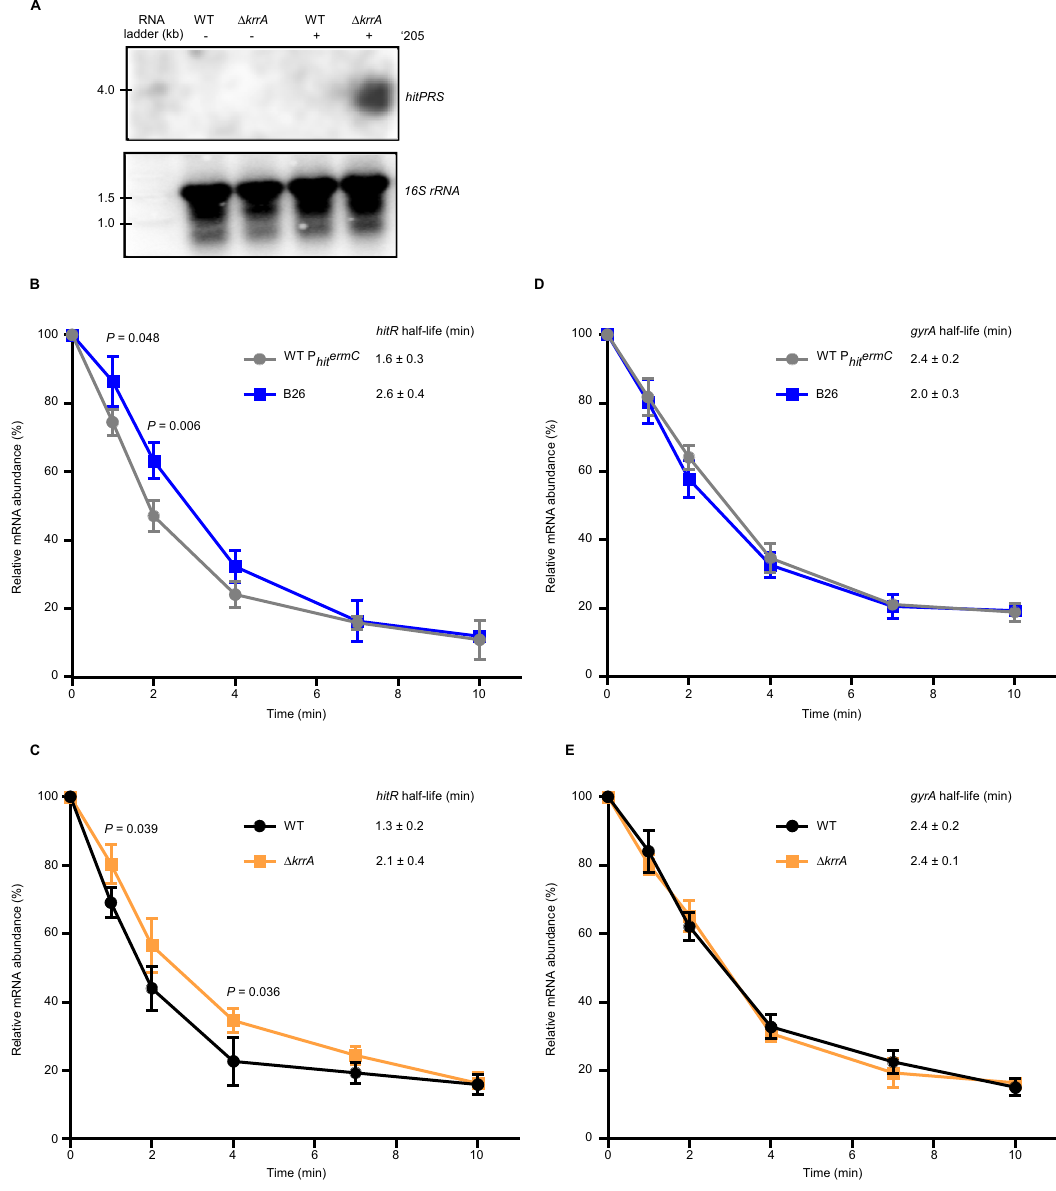
Fig. 2 The HitRS signaling system is fi nely tuned by KrrA through modulating mRNA stability. A To examine the effects of krrA deletion on the stability of hitPRS transcripts, northern blot analysis was carried out in WT and Δ krrA in the presence or absence of ‘ 205 using a pool of four sequence-speci fi c probes against hitPRS . The housekeeping gene 16 S rRNA serves as a sample loading control. The experiments were performed at least three times and representative images are shown. Source data are provided as a Source Data fi le. The mRNA stability of hitR ( B , C ) and gyrA ( D , E ) was examined in two sets of strains: B. anthracis WT P hit ermC and B26 suppressor mutant ( B , D ), and WT and Δ krrA ( C , E ). Relative abundance of hitR ( B , C ), or gyrA ( D , E ) was quanti fi ed using qPCR. The housekeeping gene gyrA serves as a negative control. The mRNA half-life was determined using a single exponential decay model. Data shown are three biological replicates (mean ± SD). Signi fi cant differences are determined by two-tailed t